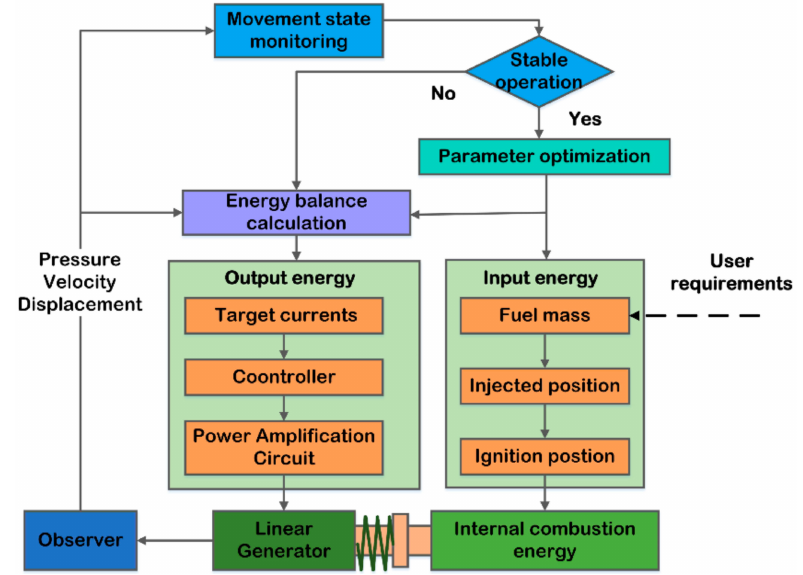
Figure 11. The control strategy